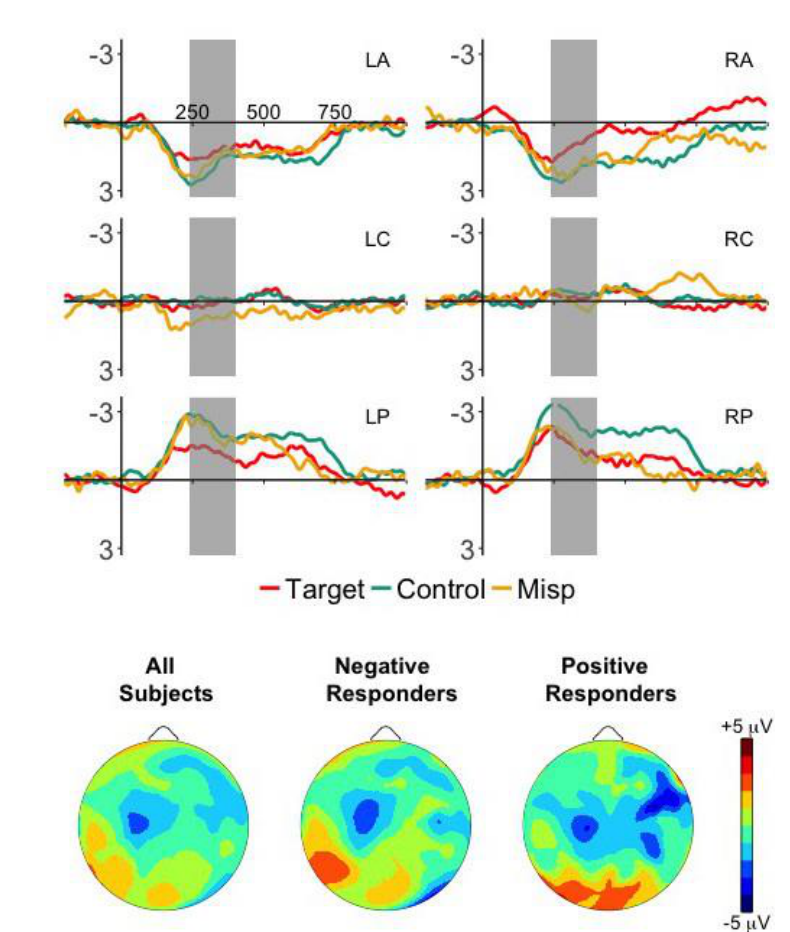
Figure 7. ( a ) Grand-average event-related potentials ERP responses time-locked to word onset for target words and coda consonant mispronunciations in the Test Phase for the 6 ROIs: left anterior (LA), right anterior (RA), left central (LC), right central (LR), left posterior (LP), right posterior (RP). The time window of interest, 200–400 ms is highlighted in gray. ( b ) Mean distribution plots for the ERP effect of mispronunciation sensitivity in the Test Phase (target words—coda consonant mispronunciations) in the 200–320 ms time window for overall group performance (left), Negative Responders (central), and Positive Responders (right).